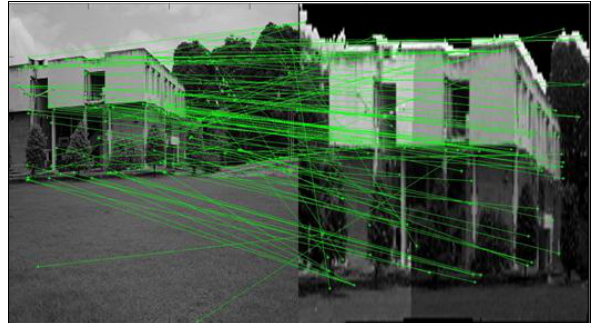
Figure 4. Matching results of camera image (left) and LiDAR intensity image